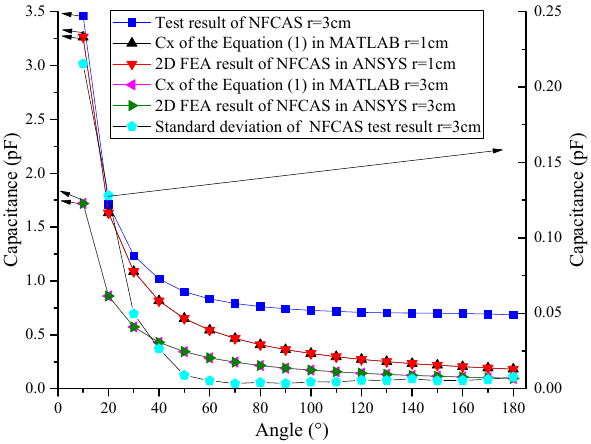
Figure 3. Results of the NFCAS in calibration experiments and analysis experiments.